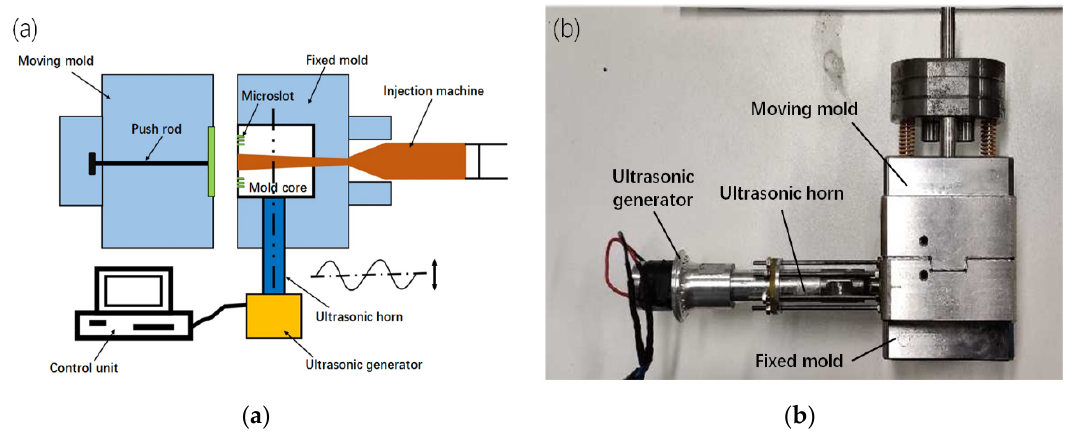
Figure 1. The ultrasonic microinjection molding platform ( a ) schematic diagram ( b ) physical map.